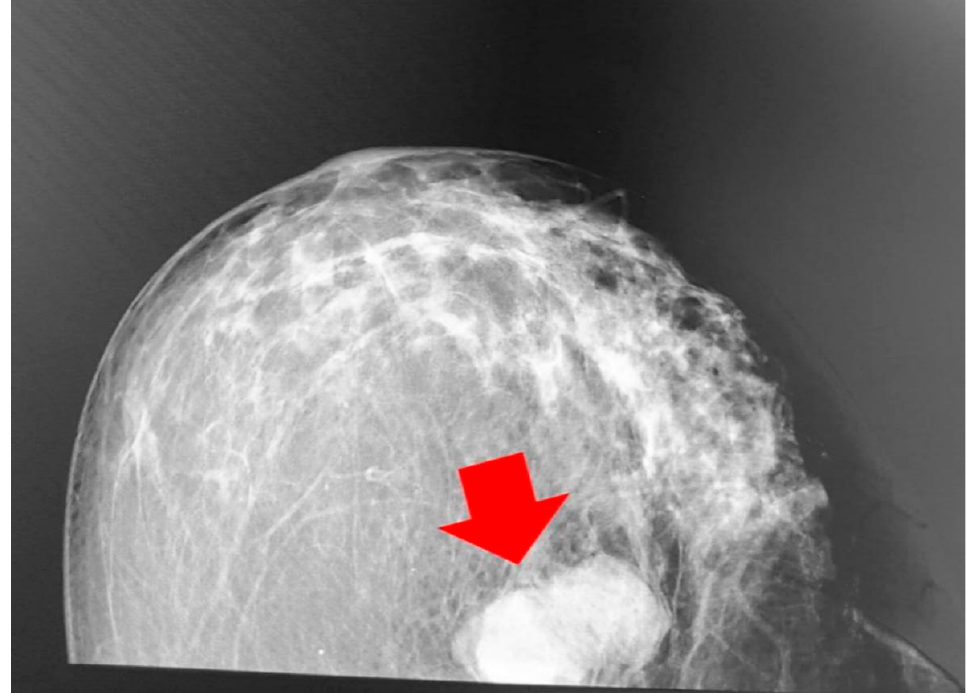
Figure 1. Findings from the mammography (craniocaudal position); a strong lobulated shadow can be observed (red arrow marks the breast LELC).